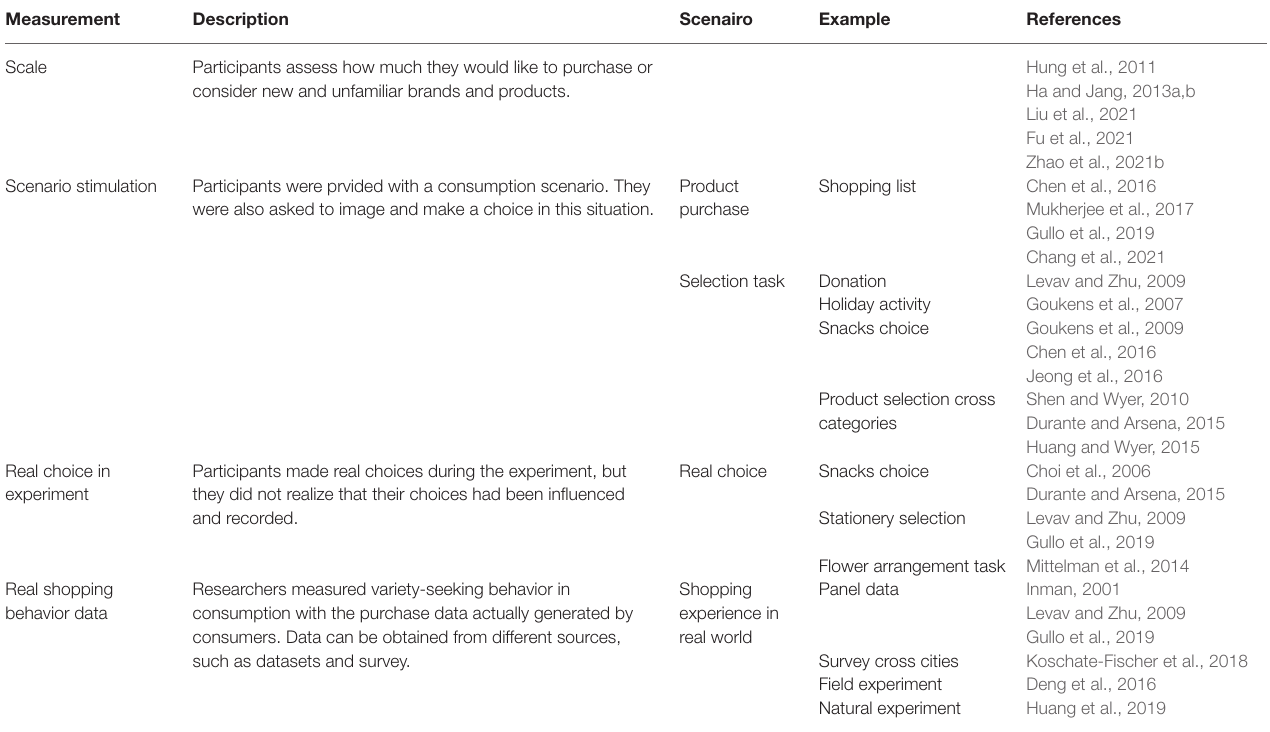
TABLE 3 | Summary of measurements of variety-seeking behavior in consumption in